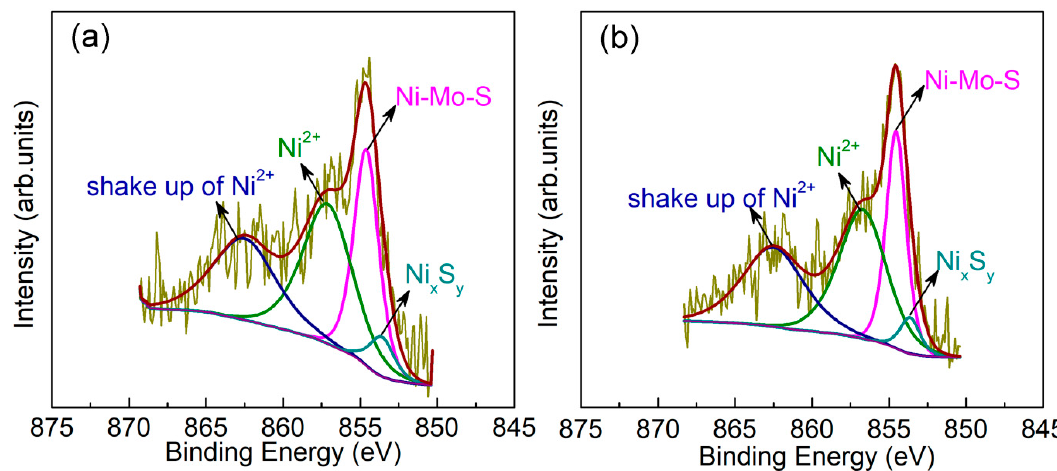
Figure 5. Peak-fittings of Ni 2p XPS spectra from ( a ) Cat C and ( b ) Cat D.